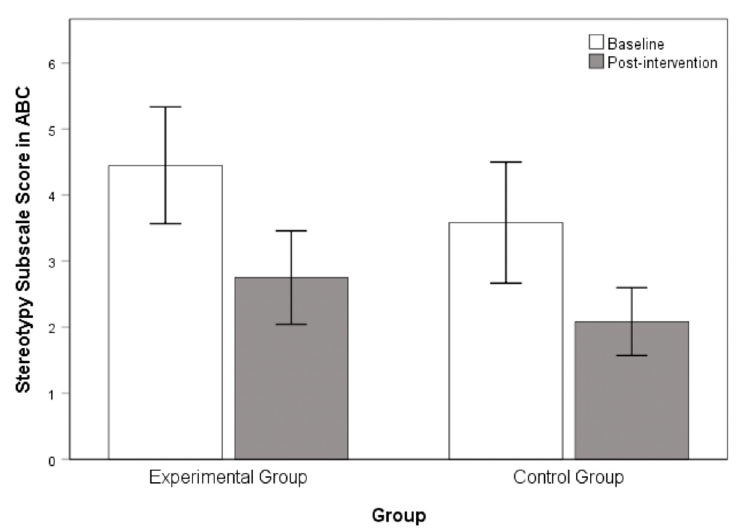
Figure 4. Mean parental rating on children’s stereotypic/repetitive behaviors in the experimental and control group before and after intervention. Both groups show a reduced score in stereotypic behaviors. ABC = Aberrant Behavior Checklist . Error bars represent 1 standard error ± mean.